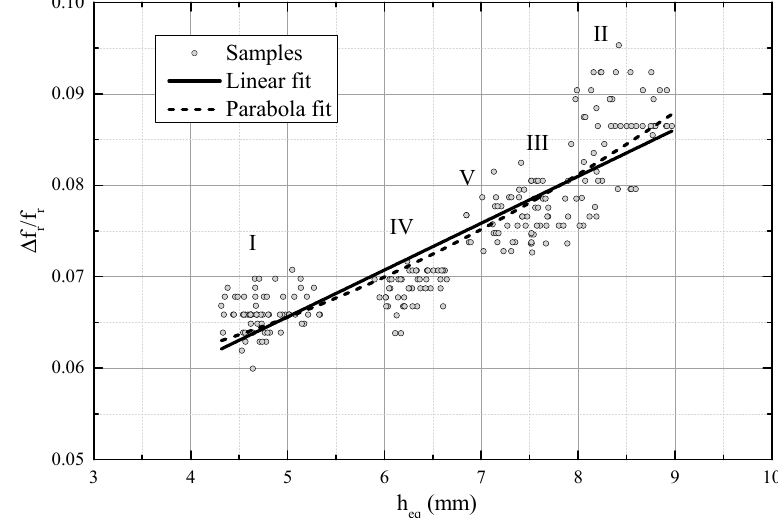
Figure 7. Thickness of the equivalent water layer vs. the relative resonant frequency shift with a reduced number of samples. A linear fit (R 2 = 0.78) and a parabola fit (R 2 = 0.82).